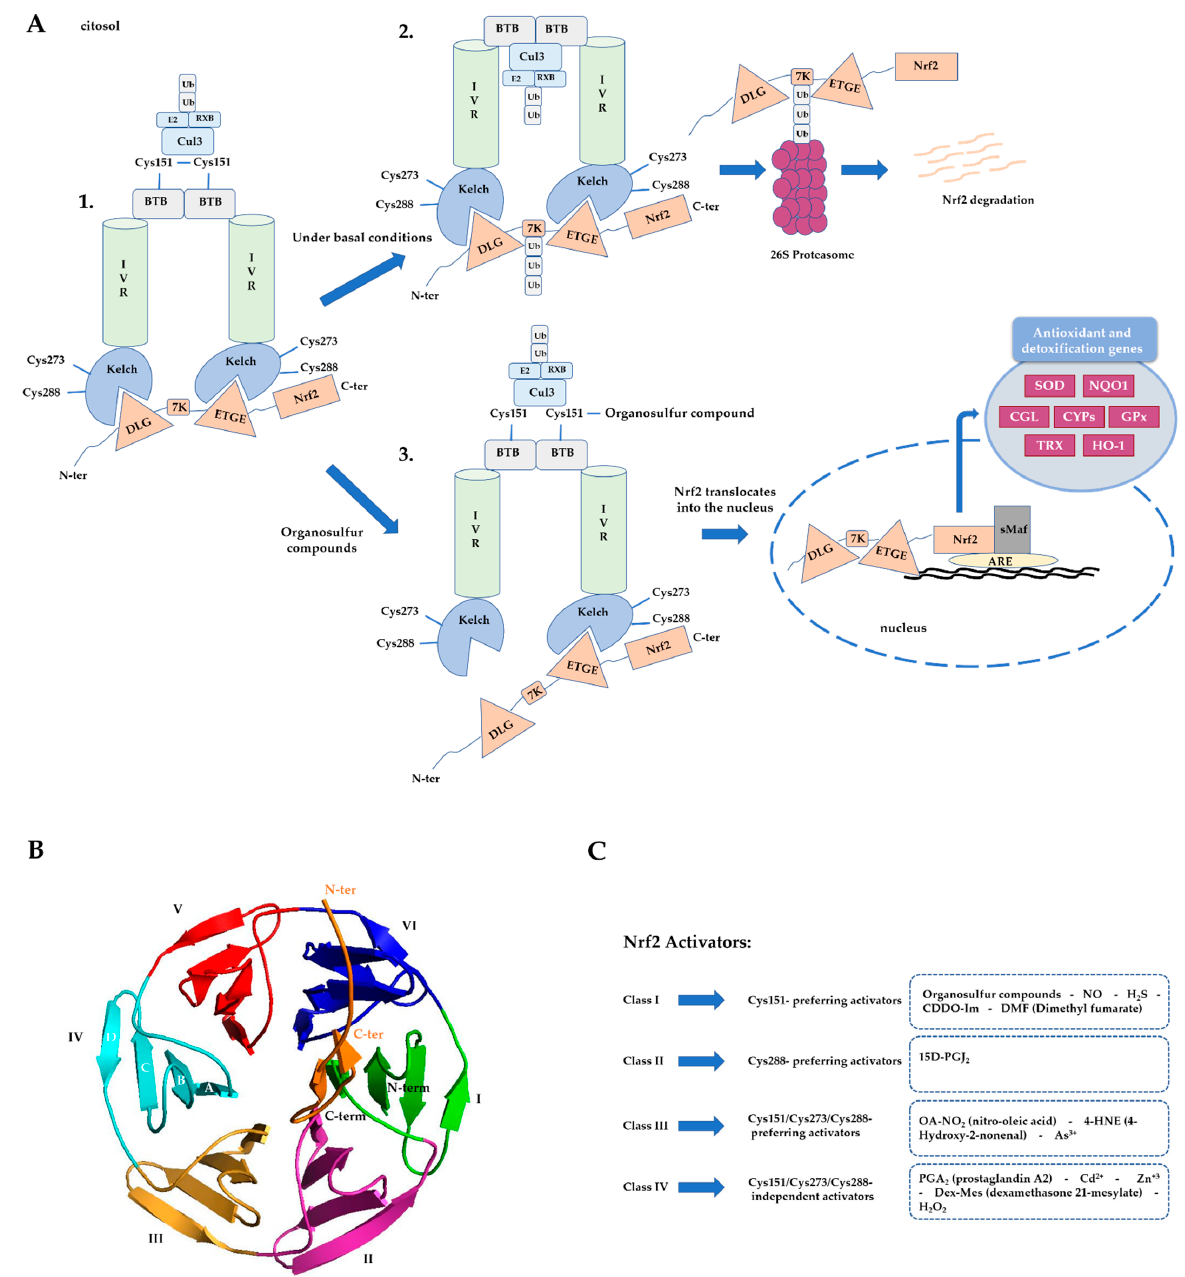
Figure 2. ( A ) Regulation of Nrf2 activity by Keap1. ( 1. ) Keap1 in dimeric form, complexed with Nrf2. ( 2. ) Under basal conditions, Nrf2 interacts with Keap1 homodimer through ETGE and DLG